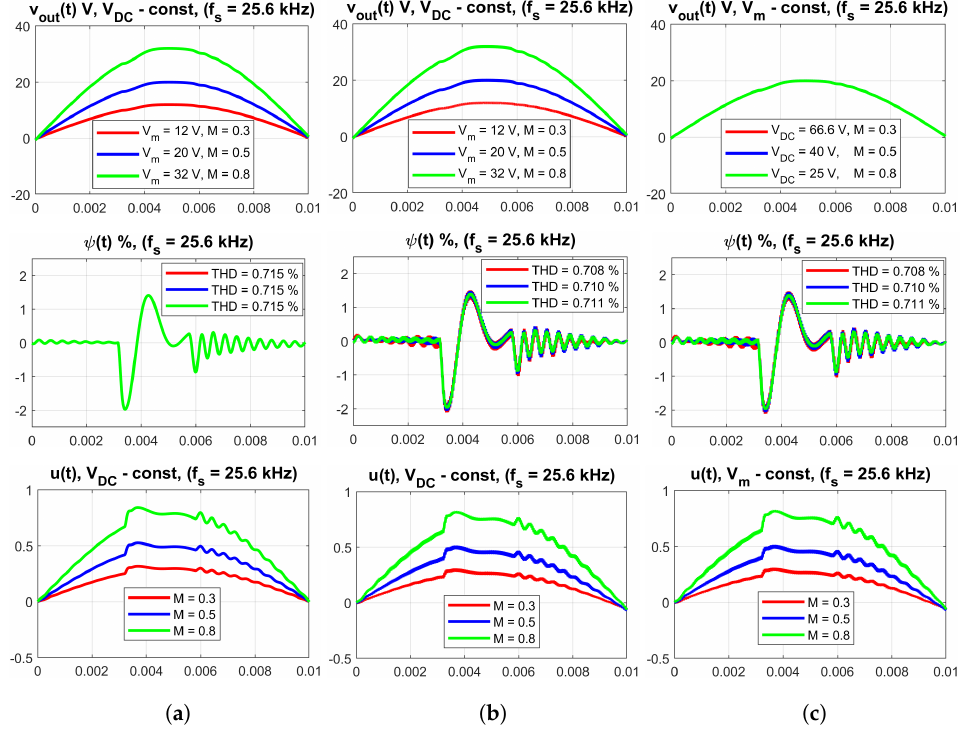
Figure 24. Comparison of simulated control results at various values of the modulation index M . ( a ) QCT simulation, V DC = 40 V, different values of V m ; ( b ) PWM simulation, data the same as in ( a ); ( c ) PWM simulation, V m = 20 V, various values of V DC with the gain adjusted. Notice that the distortion function ψ ( t ) is practically the same in all cases, hence the quality of control does not depend on M